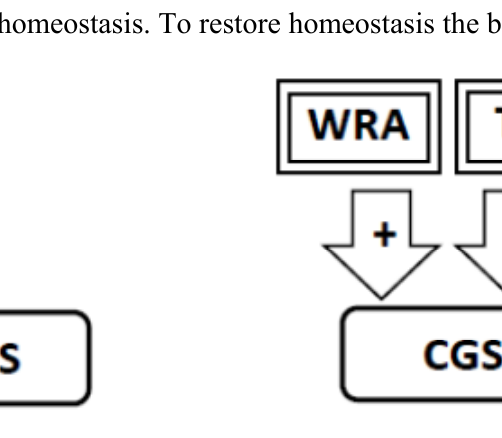
Figure 6. When cessation is attempted, the Withdrawal-Related Adaptations (WRA) and Tolerance-Related Adaptations (TRA) continue to stimulate the Craving Generation System (CGS) resulting in withdrawal-related craving in the absence of any cues. Now the stimulation of the CGS provided by the WRA and TRA is no longer restoring homeostasis but is disrupting homeostasis. To restore homeostasis the brain removes the WRA.